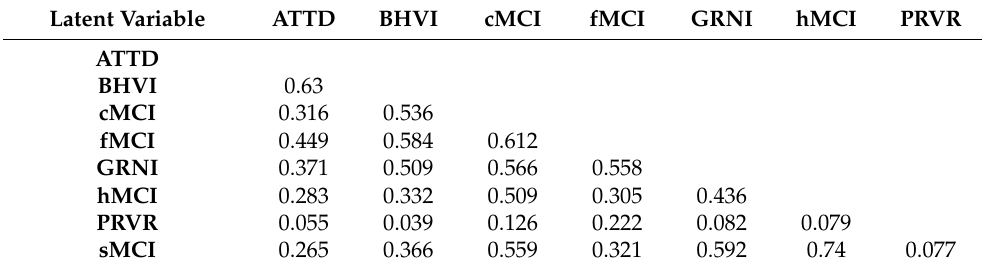
Table 6. Discriminant validity (HTMT